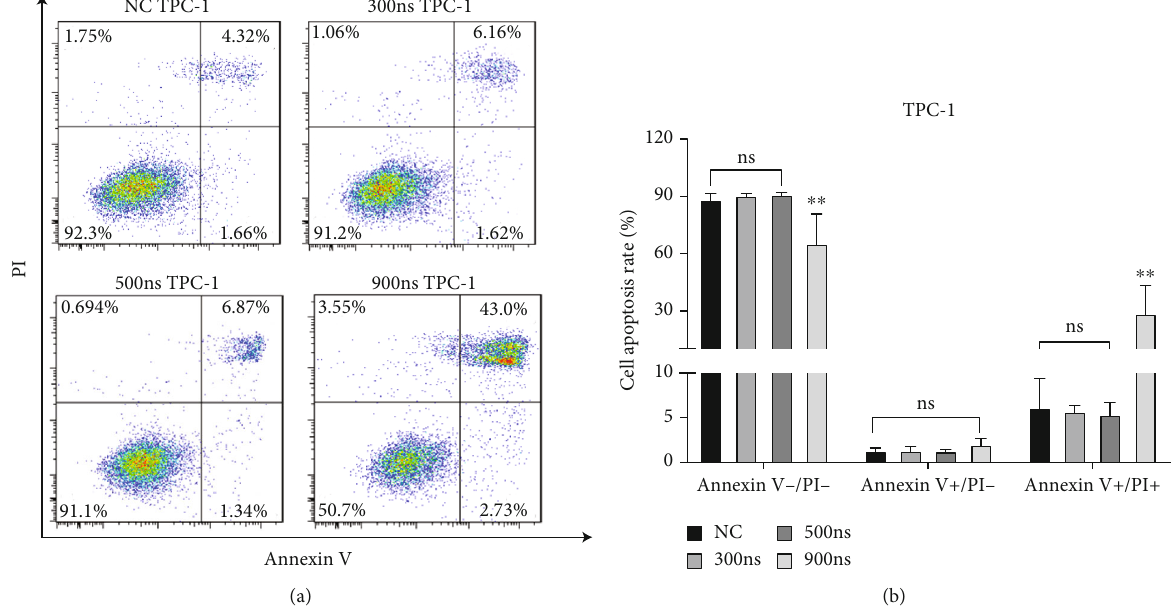
Figure 3: NsPEFs a ff ected the apoptosis of TPC-1 cells. (a) After treated with di ff erent parameters of nsPEFs, TPC-1 cell apoptosis was detected by fl ow cytometry. (b) Analysis showed that nsPEFs with 900ns pulse duration induced late apoptosis/necrosis. ∗ p < 0 : 05 ; ∗∗ p < 0 : 01 ; ∗∗∗ p < 0 : 001